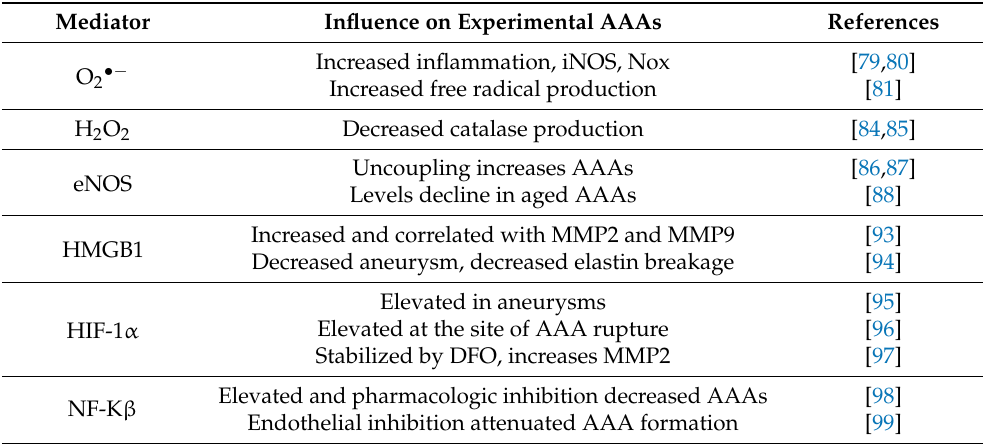
Table 1. Mediators of Nox signaling in experimental